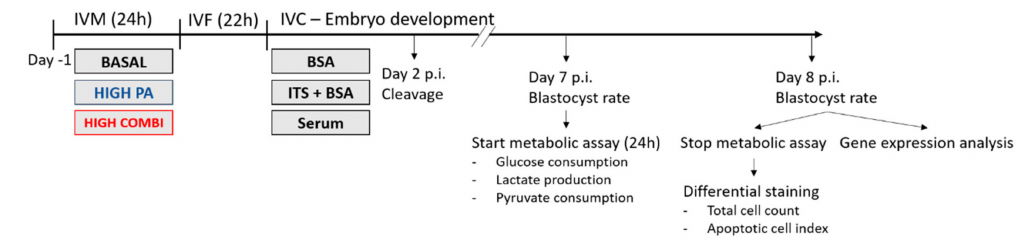
Figure 5. Overview of the experimental